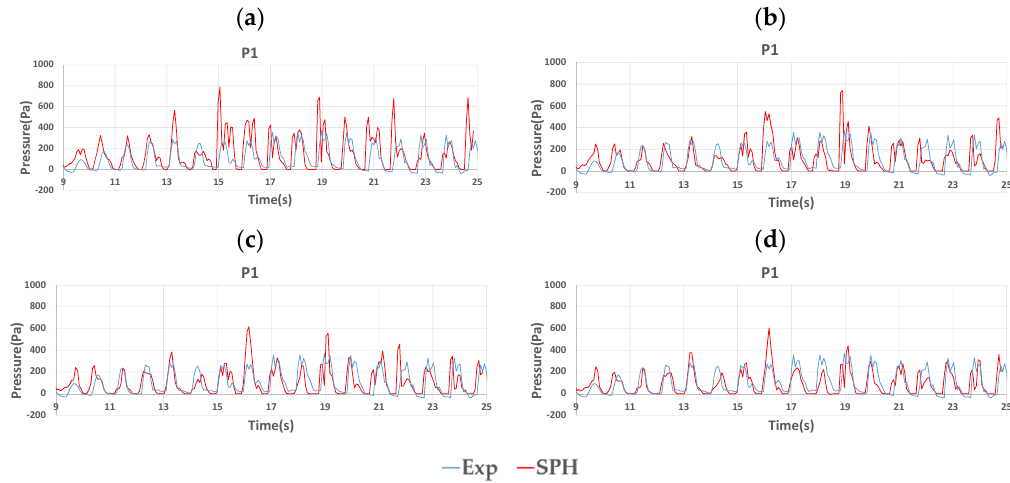
Figure 6. Influence of the speed of sound on hydrodynamic pressure: coefsound = ( a ) 20, ( b ) 40, ( c ) 60, and ( d ) 80. Table 5. Natural frequencies of the prismatic tank at different filling ratios.